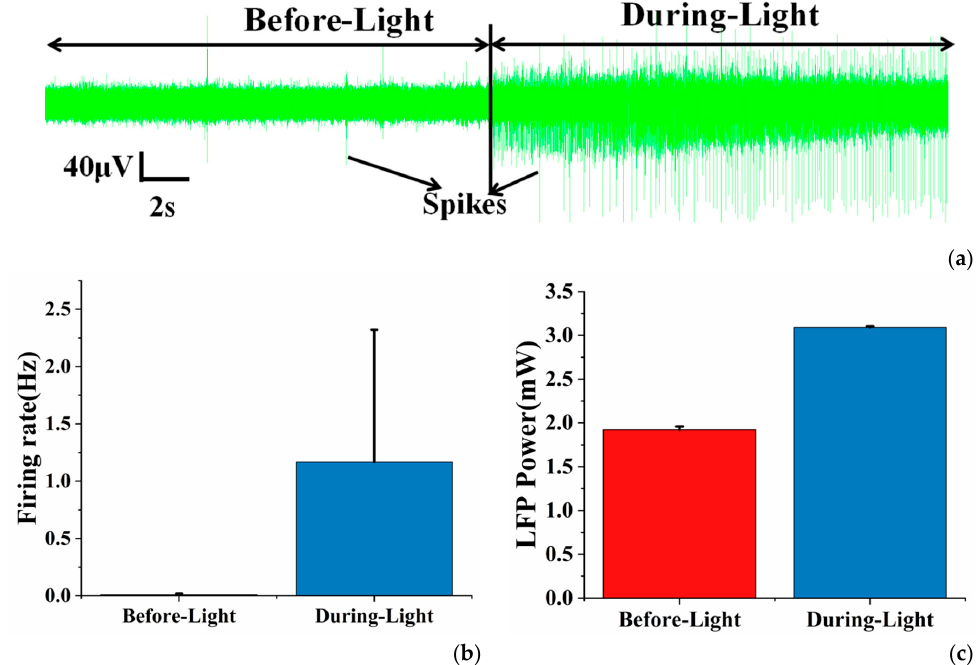
Figure 2. ( a ) The real-time recordings of electrophysiological signals before and during light illumination in viral transfection areas; ( b ) the average spike firing rate of neurons before and during optical stimulation; ( c ) the mean LFP power (0–30 Hz) of neurons before and during optical stimulation. Error bars indicate standard deviation of 3